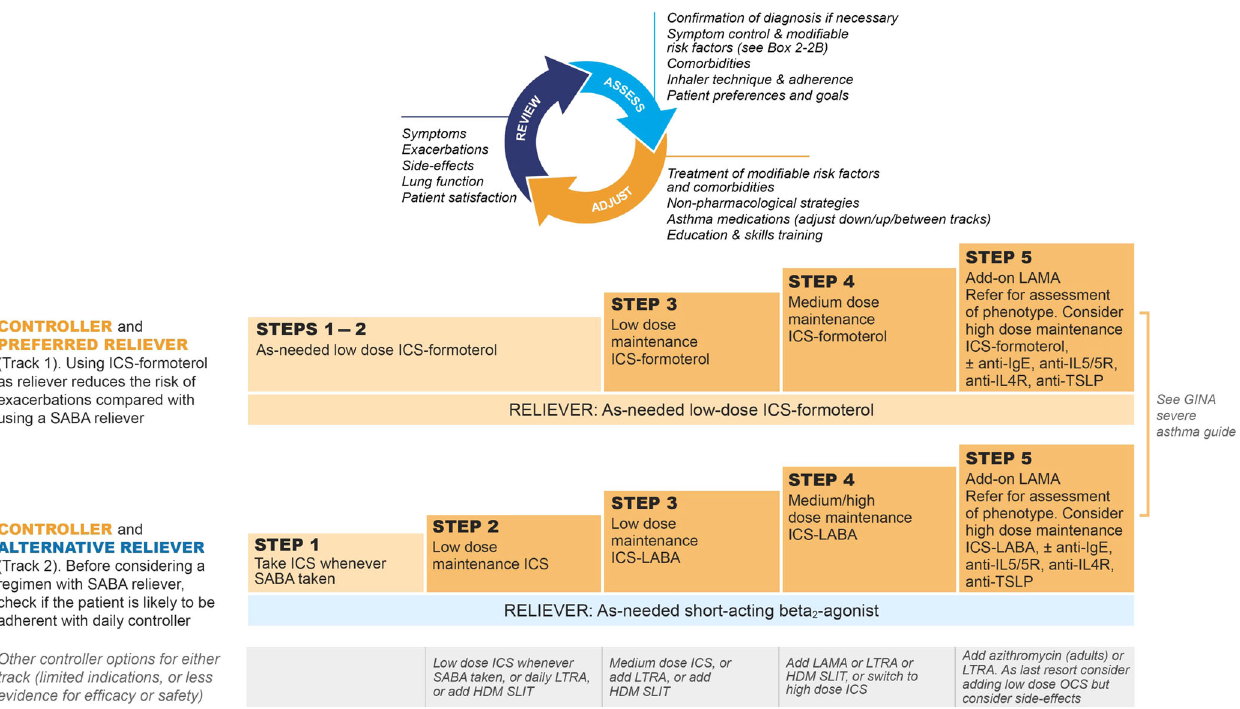
Fig. 4 Two-track options for personalized management of asthma for adults and adolescents, to control symptoms and minimize future risk. HDM house dust mite, ICS inhaled corticosteroid, LABA long-acting beta 2 agonist, LAMA long-acting muscarinic antagonist, LTRA leukotriene receptor antagonist, OCS oral corticosteroids, SABA short-acting beta 2 agonist, SLIT sublingual immunotherapy. Box number refers to the GINA 2022 report. Before starting, stepping up or down or switching between tracks, patients should be assessed using the “ assess, adjust, review ” cycle shown at the top of the fi gure. Refer to the GINA report for more information about Step 5 options, including biologic therapies for patients with severe asthma. Source: Box 3 – 5A in GINA report 2022. Reproduced with permission from ref. 11 .